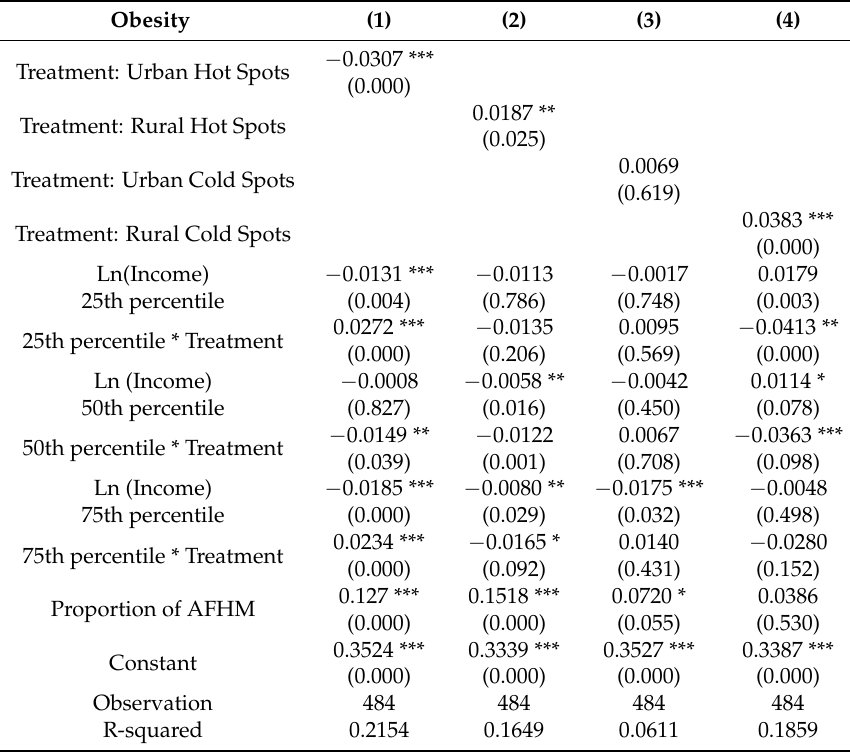
Table A8. Kernel matching results for obesity.